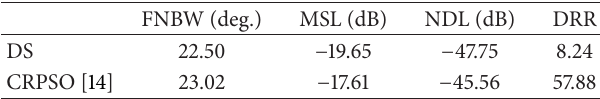
Table 3: FNBW, MSL, NDL, and DRR values obtained by DS and CRPSO [14] for the third example (20 elements).